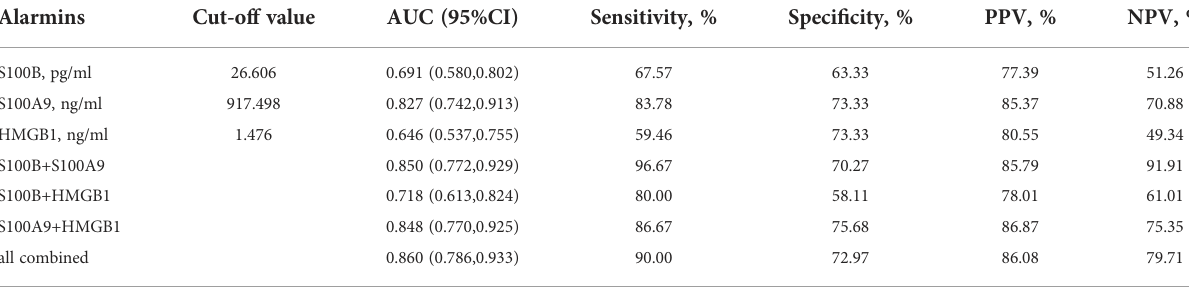
TABLE 4 Diagnostic values of biomarkers for the prediction of vitiligo activity.